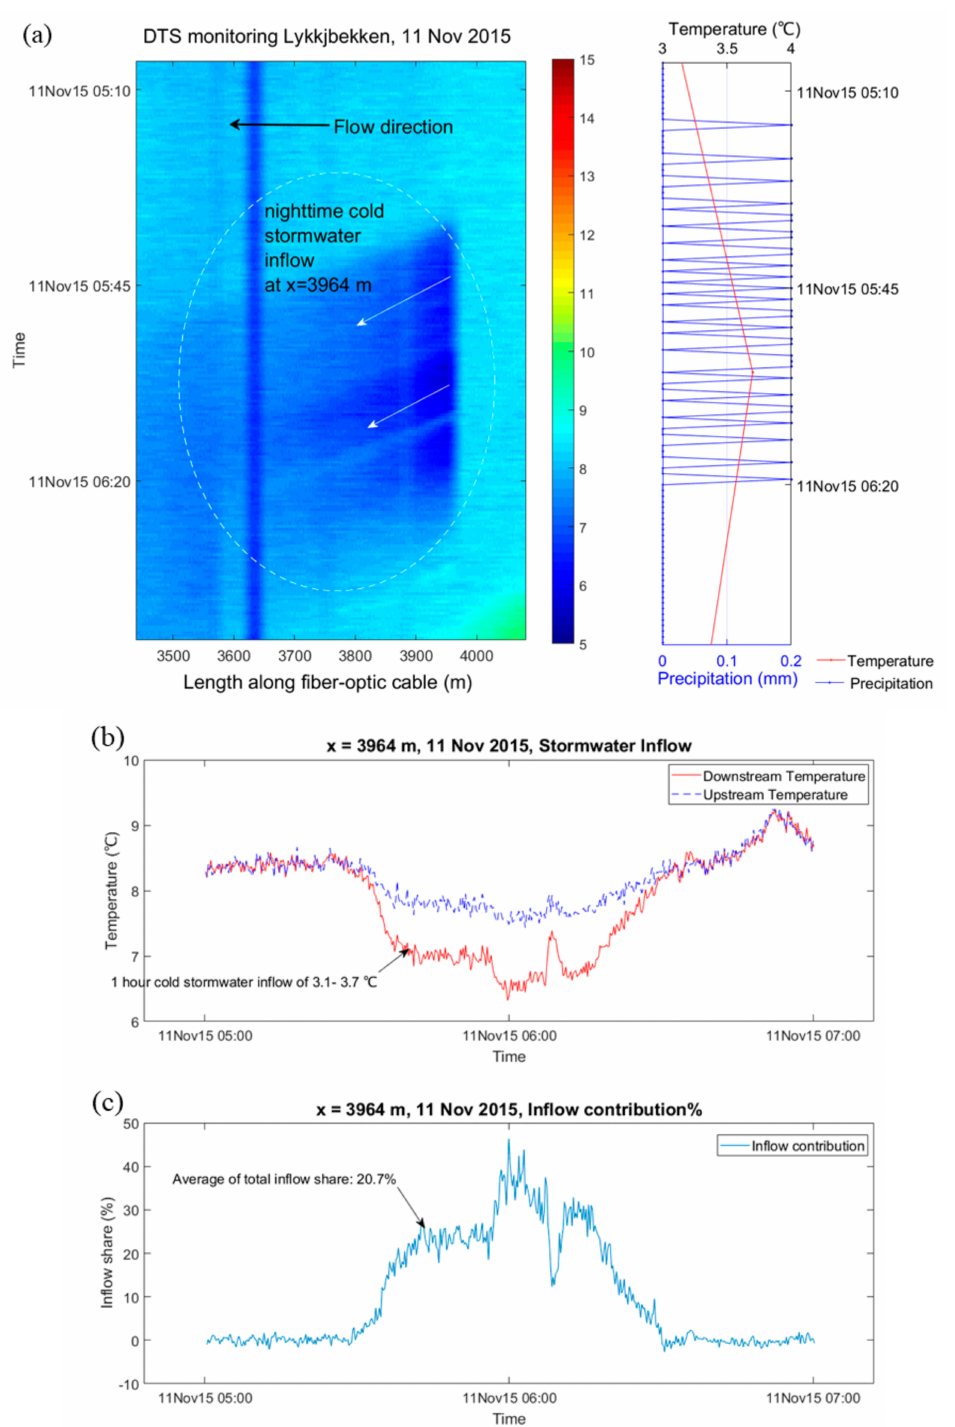
Figure 10. ( a ) DTS monitoring results around the rainfall-derived I/I point of x = 3964 m in storm event of 11 November 2015; ( b ) the upstream and downstream temperatures around real stormwater infiltration at x = 3694 m; ( c ) percentage of I/I share in comparison with the upstream